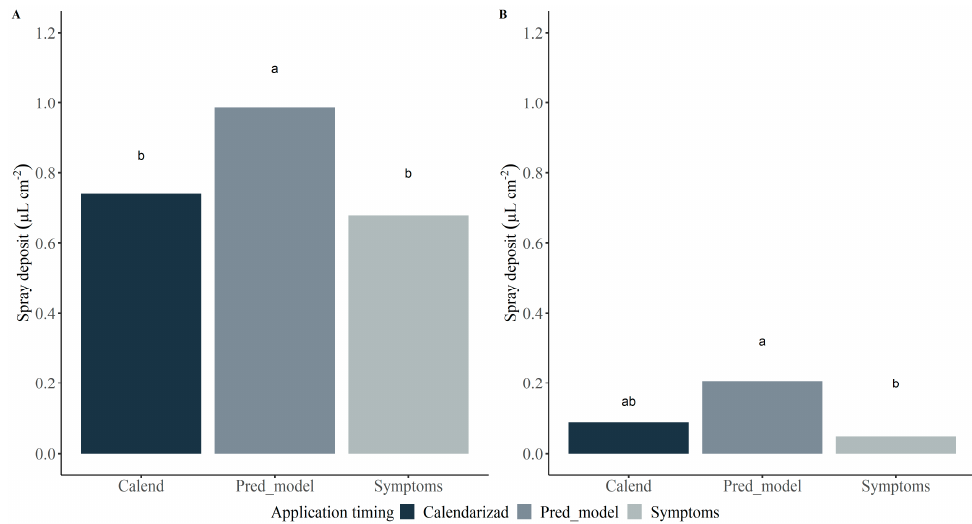
Figure 6. Mean deposit values ( μ L cm − 2 ) that were collected in the upper ( A ) and lower ( B ) regions of the soybean canopy at different application timings in the second application of Field 1. The means followed by the same letter did not differ by the Tukey’s test at 5% probability ( p < 0.05) in each comparison.